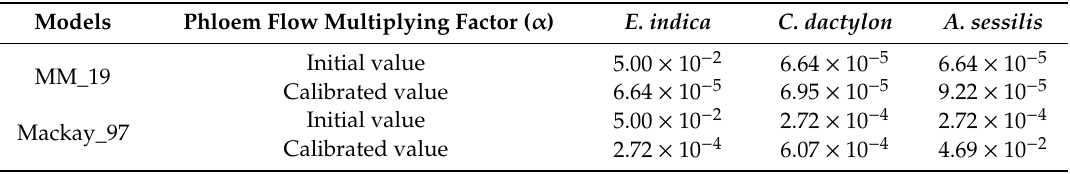
Table 1. Initial and calibrated values of the phloem flow multiplying factor ( α ).